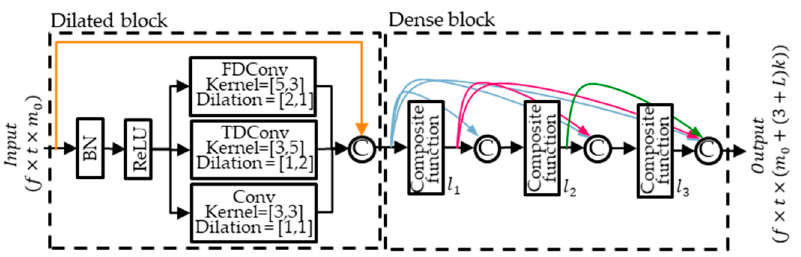
Figure 1. The architecture of dilated dense block. The [frequency, time] denotes the kernel size and dilation rate. BN: batch normalization, ReLU: rectified linear unit, FDConv: frequency dilated convolution, TDConv: time dilated convolution.